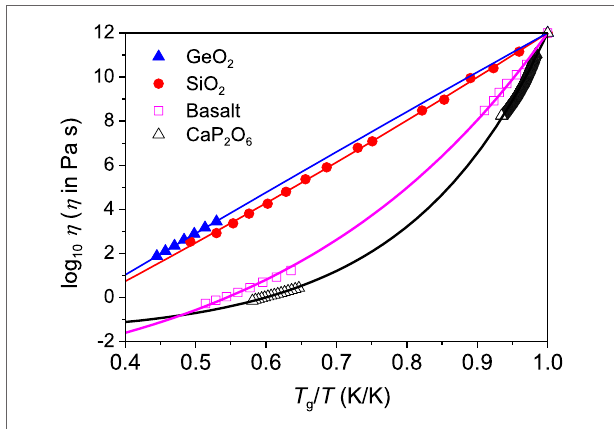
FigUre 3 | Fragility plots (viscosity η versus the T g -scaled temperature T ) of the four systems . Symbols represent the measured viscosity data of GeO 2 (Hornbøll and Yue, 2008b), SiO 2 (Urbain et al., 1982), basalt (this work), and CaP 2 O 6 (Yue, 2002). Solid lines show the fits of the measured data to the Eq. (1). The T g values of GeO 2 , basalt, and CaP 2 O 6 are given in Table 1 , and the T g value of silica (Urbain et al., 1982) is 1406 K. The fragility index m was found to be 18, 20, 44, and 69 for GeO 2 , SiO 2 , Basalt, and CaP 2 O 6 ,